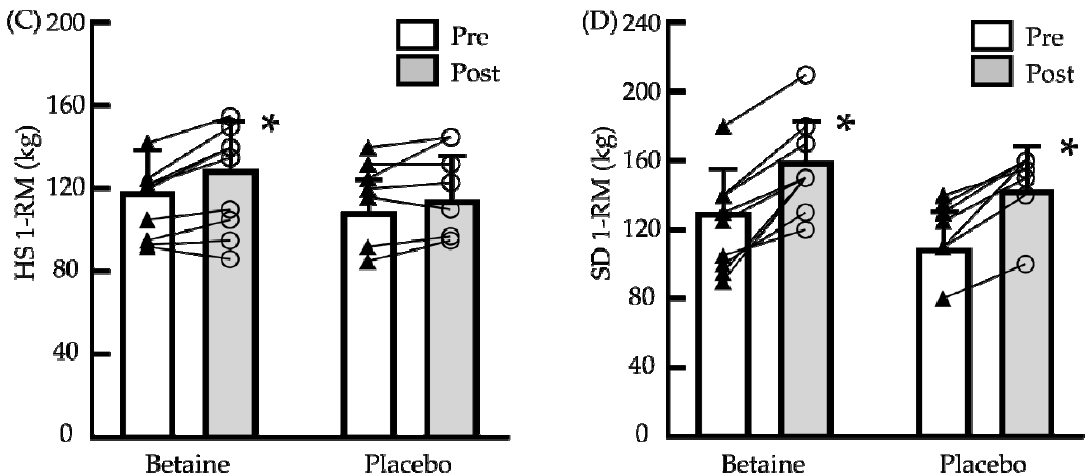
Figure 2. Changes in the one repetition maximum (1-RM) before and after 6 weeks of betaine supplementation. ( A ) Bench press (BP); ( B ) overhead press (OP); ( C ) half squat (HS); and ( D ) sumo dead lift (SD). Pre: before supplementation; Post: after supplementation. The bars indicate means ± standard deviation. ▲ : Individual presupplementation values; ○ : individual postsupplementation values; *: significant difference from Pre ( p < 0.05).